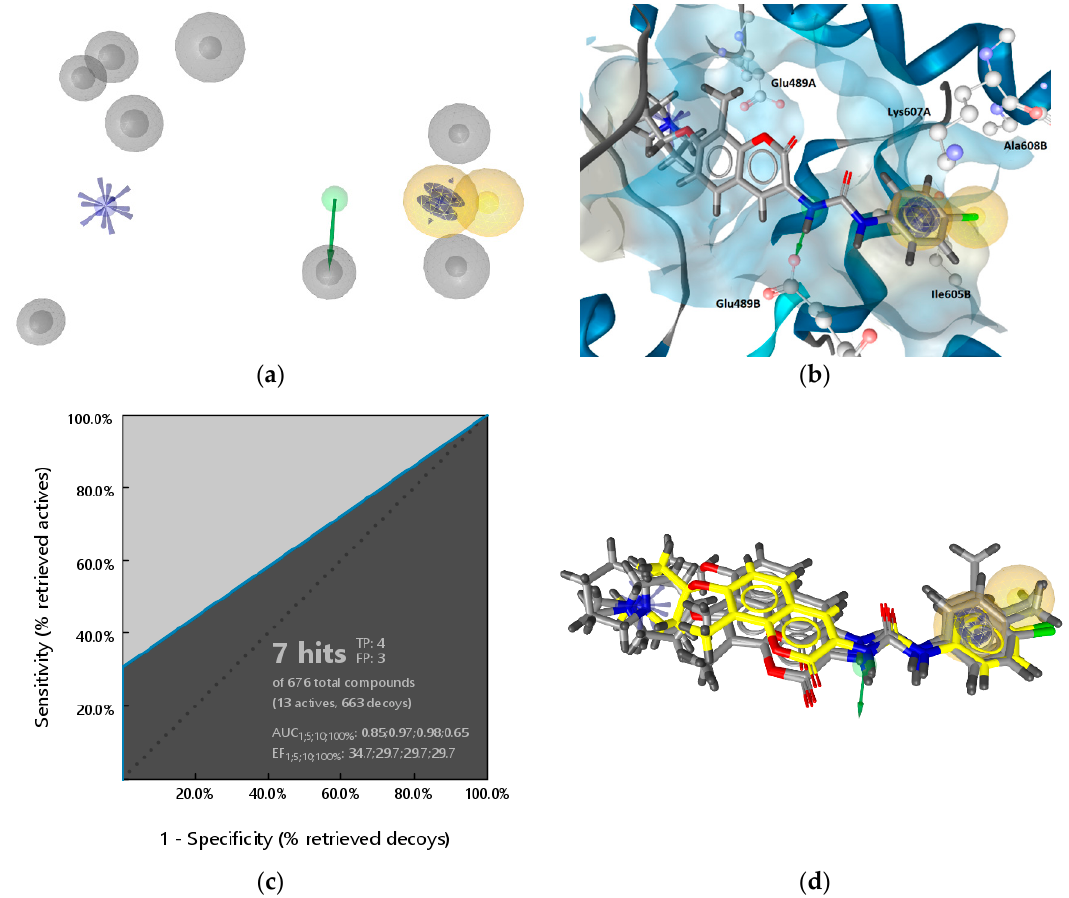
Figure 8. ( a ) The molecular dynamics (MD)-derived structure-based (SB) pharmacophore model prioritized for virtual screening and ( b ) binding mode of 2 with pharmacophore features derived from MD simulations. For clarity, only amino acids interacting with the ligand are shown. The pharmacophore features are as follows: hydrophobic (yellow spheres), aromatic (blue disc), hydrogen bond donor (green arrow), positive ionizable (blue star), exclusion volumes (grey spheres). ( c ) Resulting ROC plot (curve shown in blue), from virtually screening 676 compounds (13 Hsp90 CTD actives and 663 generated decoys) with the SB pharmacophore model. TP = true positives; FP = false positives; AUC = area under the curve; EF = enrichment factor. ( d ) Alignment of four hits with SB-model derived from Hsp90 β allosteric CTD domain MD simulations. Compound 2 is highlighted in yellow.